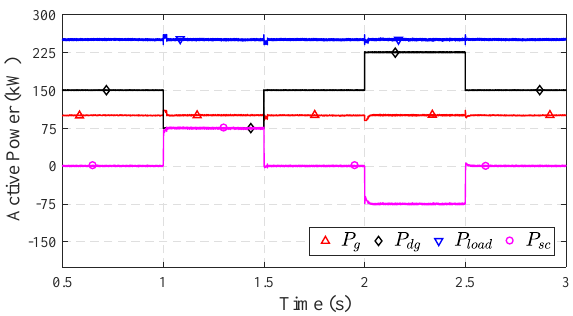
Figure 13. Three-phaseactivepowersof thegrid, DG,load andsmartchargershowing V2GandG2Vaction.